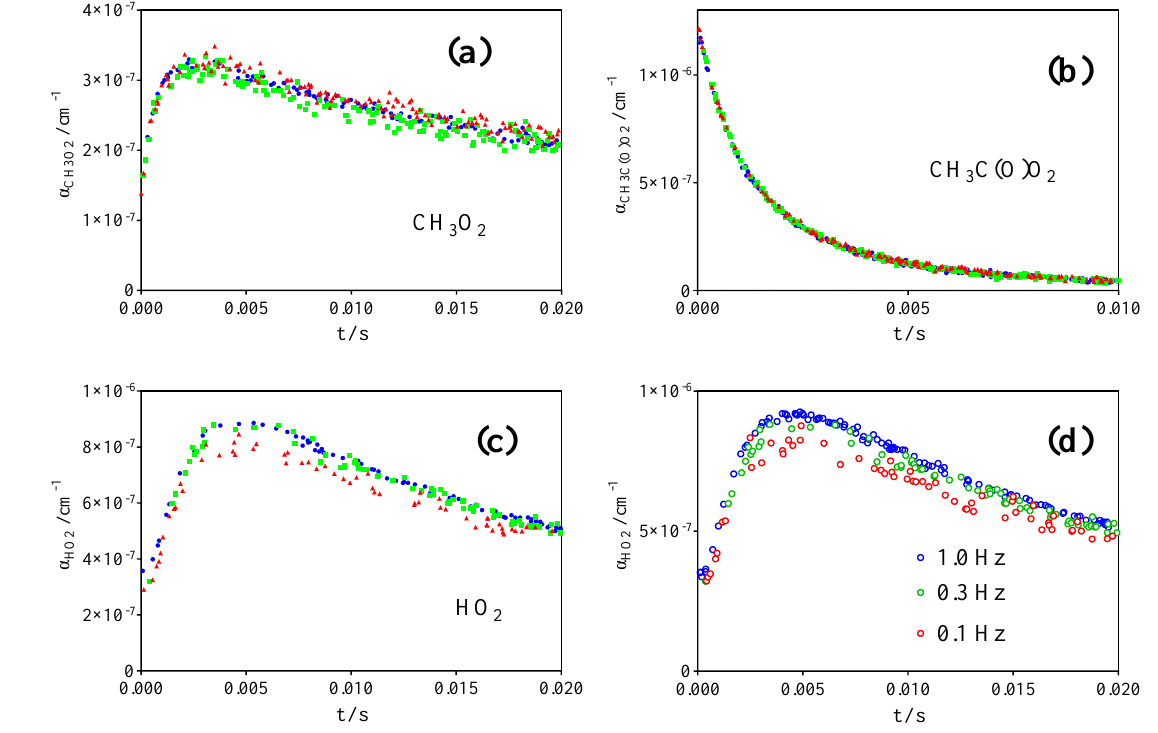
Figure 10. Test for unidentified secondary chemistry involving CH 3 CHO or reaction products remaining within the photolysis volume: ( a ) CH 3 O 2 • , ( b ) CH 3 C(O)O 2 • , ( c ) HO 2 • profiles at different CH 3 CHO concentrations (Cl 2 = 7.7 × 10 15 cm − 3 , CH 3 CHO = 3.1 (blue), 6.2 (green) and 9.2 × 10 15 cm − 3 (red)). ( d ) HO 2 • profiles at different photolysis repetition